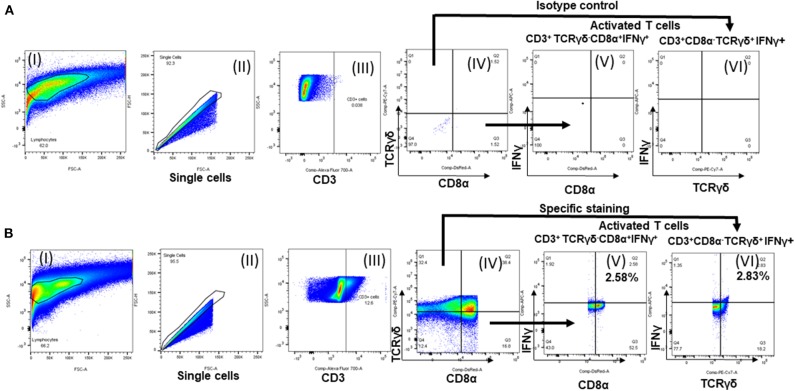
Flow cytometry analysis of splenocytes of vaccinated and challenge birds. Lymphocytes gating strategy followed to show the percentage of specific activated lymphocyte subsets. (A) Isotype control and (B) specific antibody immunostained splenocytes analysis. (I) Lymphocytes gating; (II) single cells selection; (III) cells gated initially for CD3; (IV) subdivided the CD3+ population into TCRγδ+/TCRγδ− and CD8α+/ CD8α−; IFNγ+ secreting (V) TCRγδ−CD8α+ cells and (VI) TCRγδ+CD8α− cells.